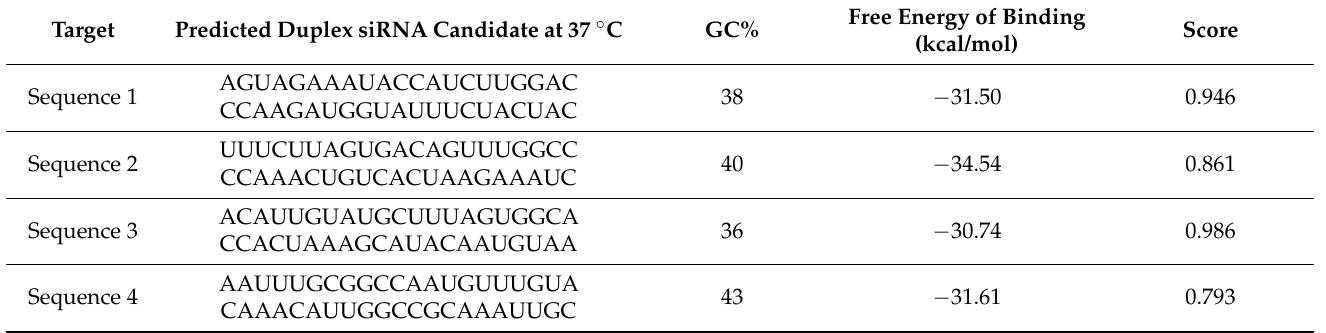
Table 3. Proposed siRNA molecules with GC%, free energy of binding, and score. Adapted from Ref. [190], Comput. Biol. Chem.